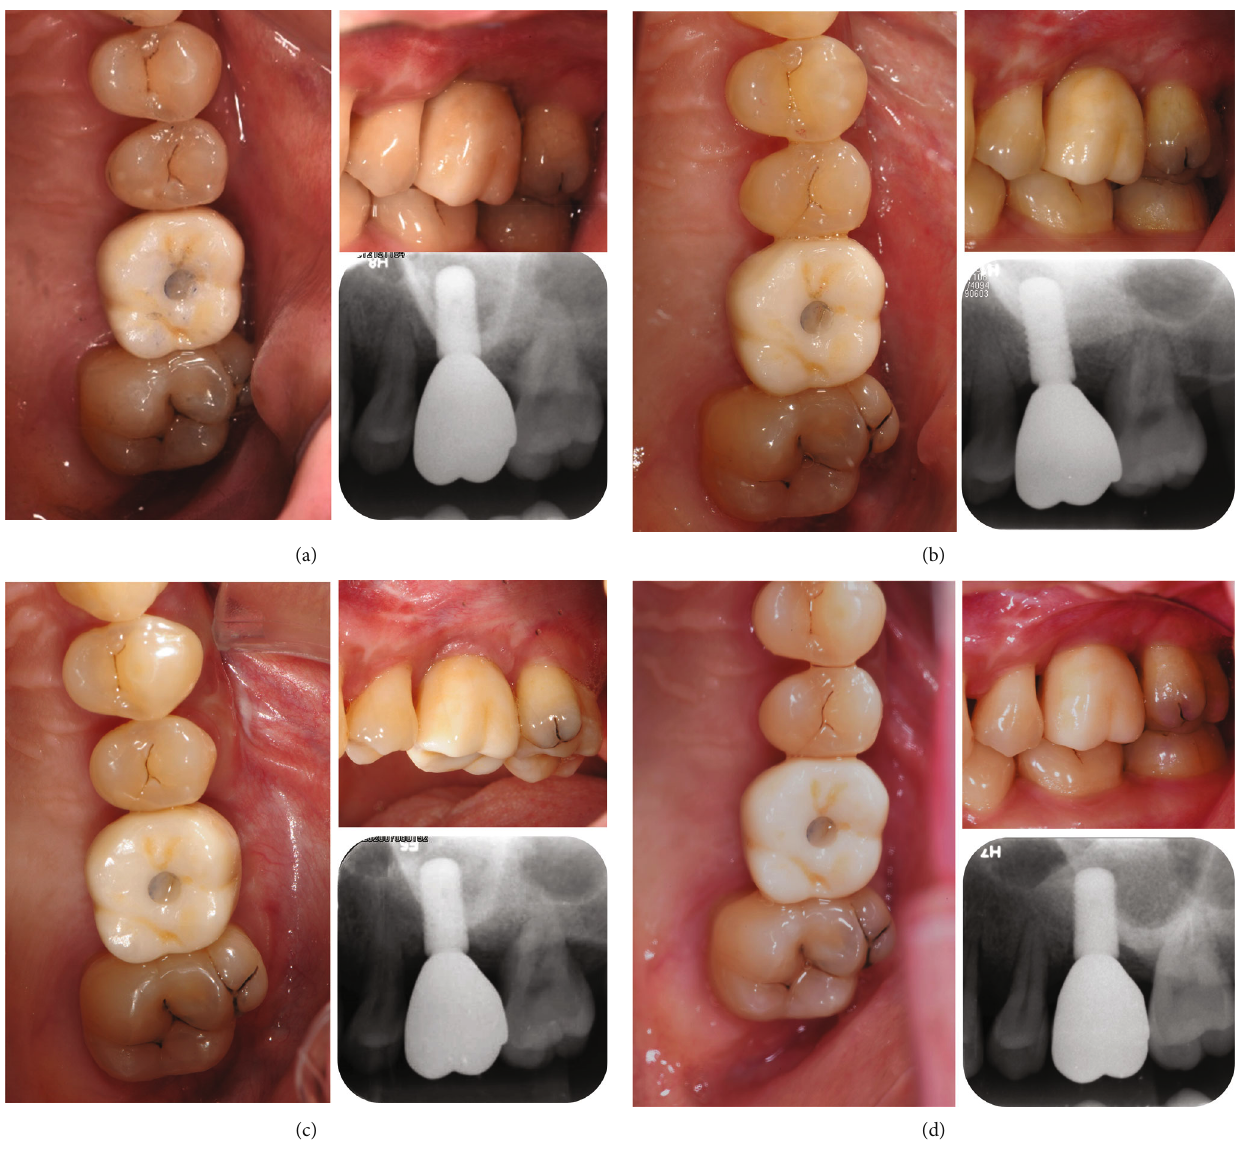
Figure 10: Periapical photographs follow-up for tooth #26. (a) Immediately after crown placement (5 months after implant placement). (b) 19 months after implant placement. (c) 28 months after implant placement. (d) 34 months after implant